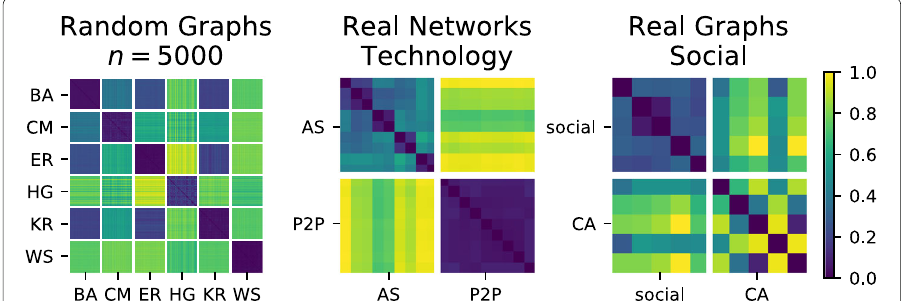
Fig. 6 NBD in synthetic and real networks. Heatmap showing the NBD values between pairs of networks in our data sets. Each panel is normalized so that the largest observed distance is 1.0 for ease of comparison. Left: random networks with n = 5,000 nodes. Middle: real network data sets P2P and AS . Right: real network data sets social and CA . twitter has been excluded from the right panel for clarity since it lies far away from most other networks (see more discussion in “Nearest neighbors”